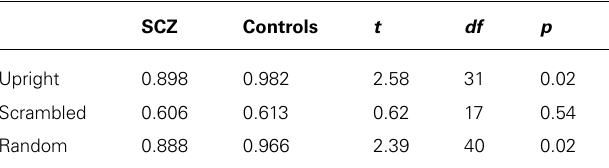
Table 3 | Mean response accuracy of participants who had an accuracy less than 1.0 in the upright and random conditions and greater than chance in the scrambled